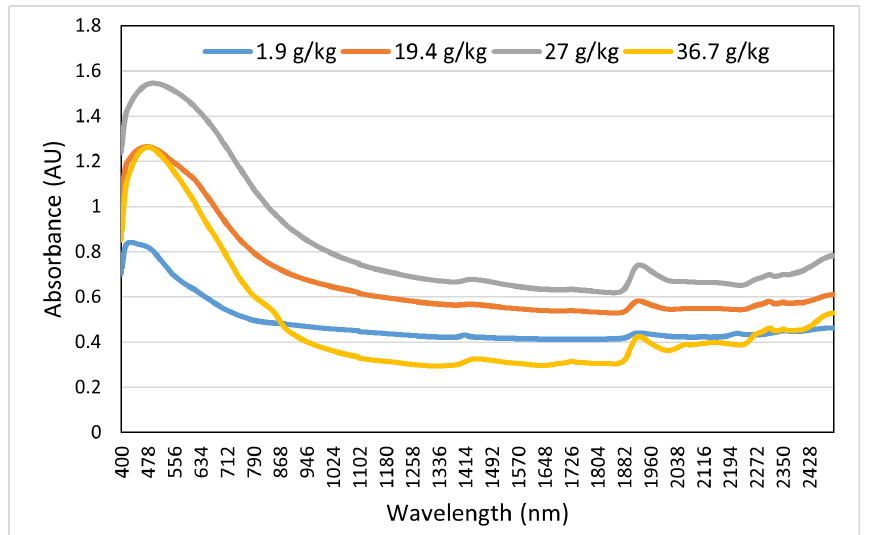
Figure 8. Absorbance of soil nitrogen content in the hyperspectral band ranging from 400 nm to 2499.5 nm.